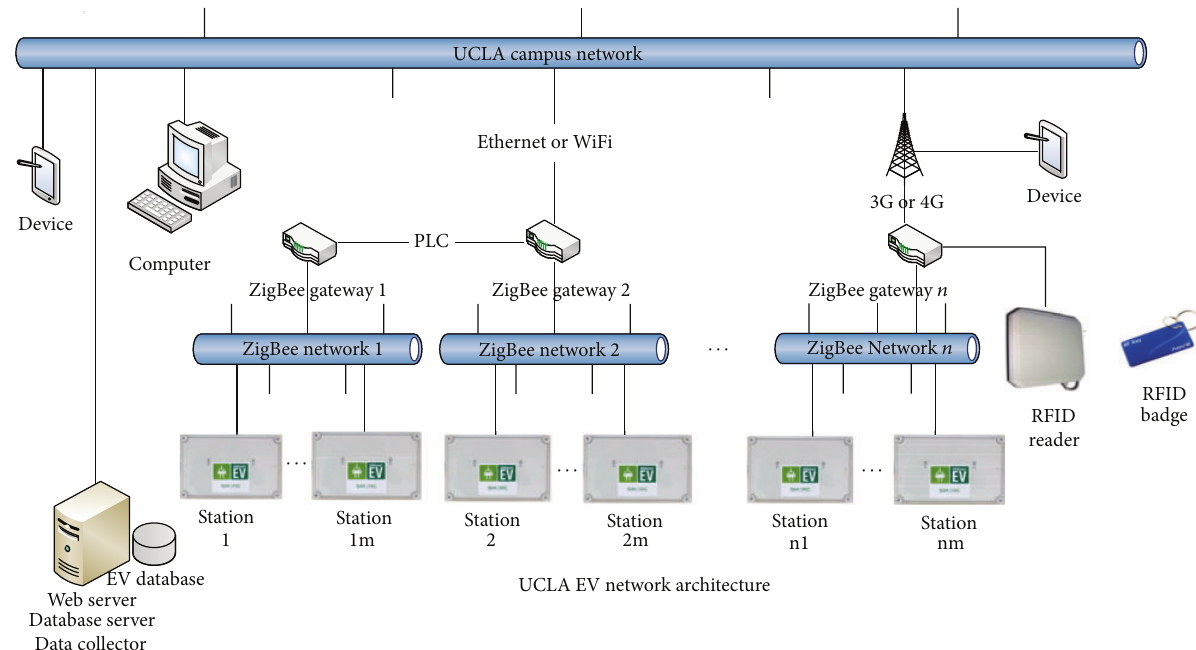
Figure 1: Network architecture of WINSmartEV.